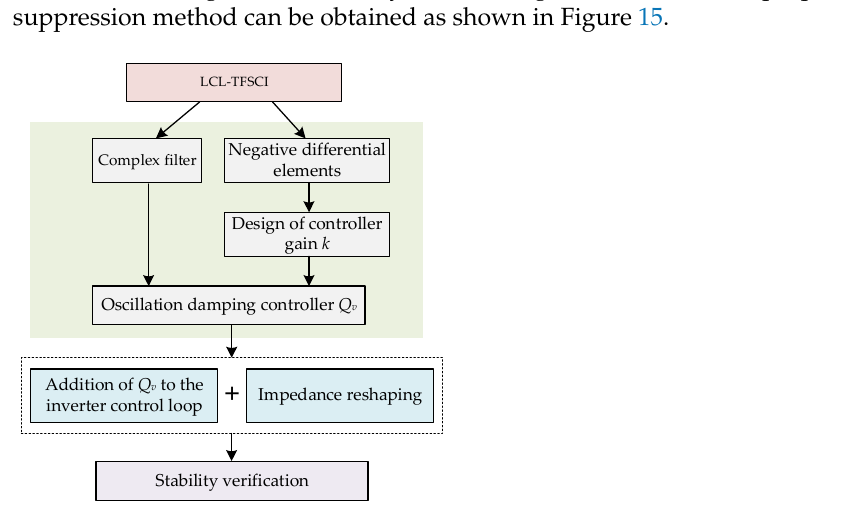
Figure 14. Bode diagram for the zero-sequence impedance of LCL-TFSCI and grid impedance when different C g is applied.